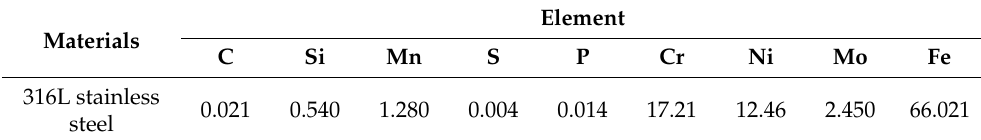
Table 2. Chemical composition of the 316L stainless steel in wt.%.